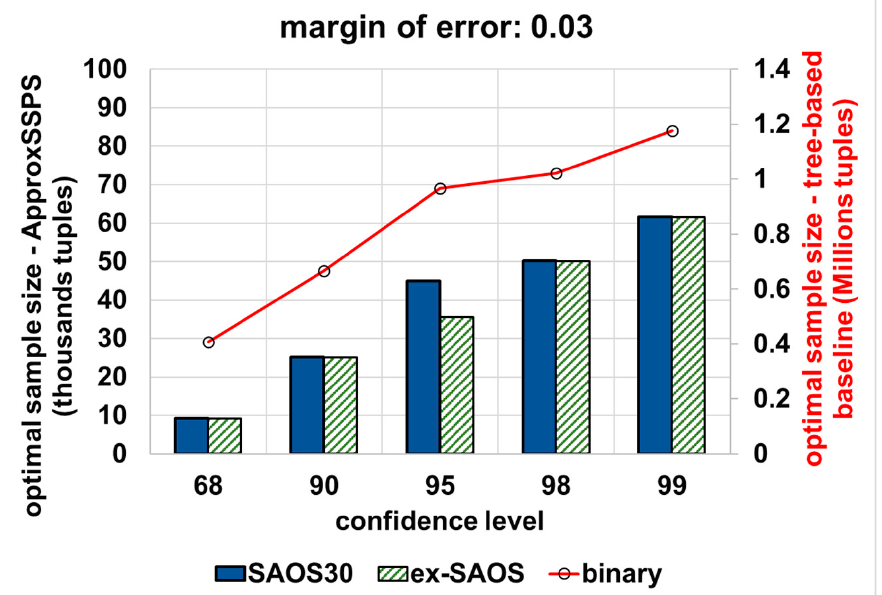
Figure 10. The optimal sample size that is required to achieve a stringent accuracy target (an error bound that equals 0.03): “computing the average ‘trip distance’ in NYC taxicabs mobility data”. ApproxSSPS with all geohash precisions and for all confidence levels achieves a significantly much lower optimal sample size as opposed to the baseline. It is, however, a discernible pattern that all methods require a higher sample size as the confidence level increases. In case of an error bound that equals 0.09, on average, the accuracy controller of Ap ‐ proxSSPS (while featuring SAOS with a geohash precision 30) needs 99.5% less data as compared to the tree ‐ based baseline. ApproxSSPS also needs around 99.4% (featuring ex ‐ SAOS in its sampler) less tuples as compared to those needed by the baseline.